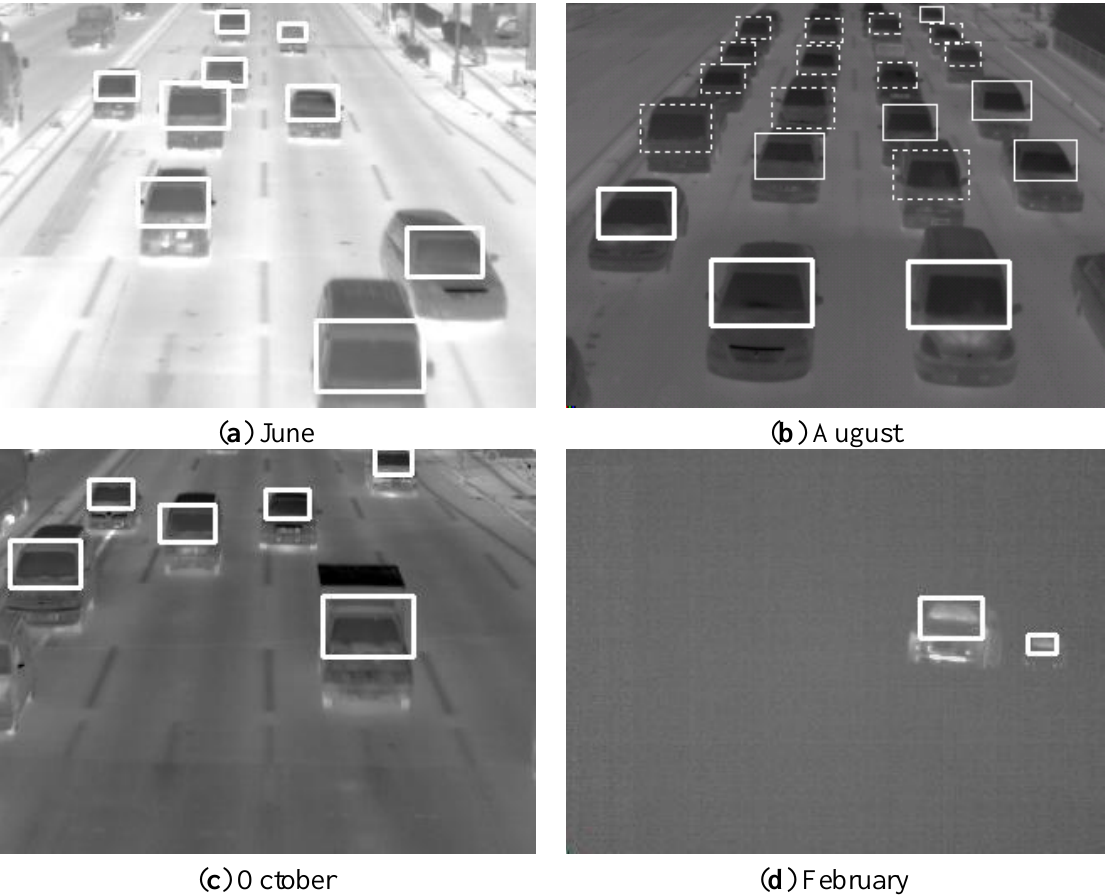
Figure 6. Some vehicle detection results in thermal images.